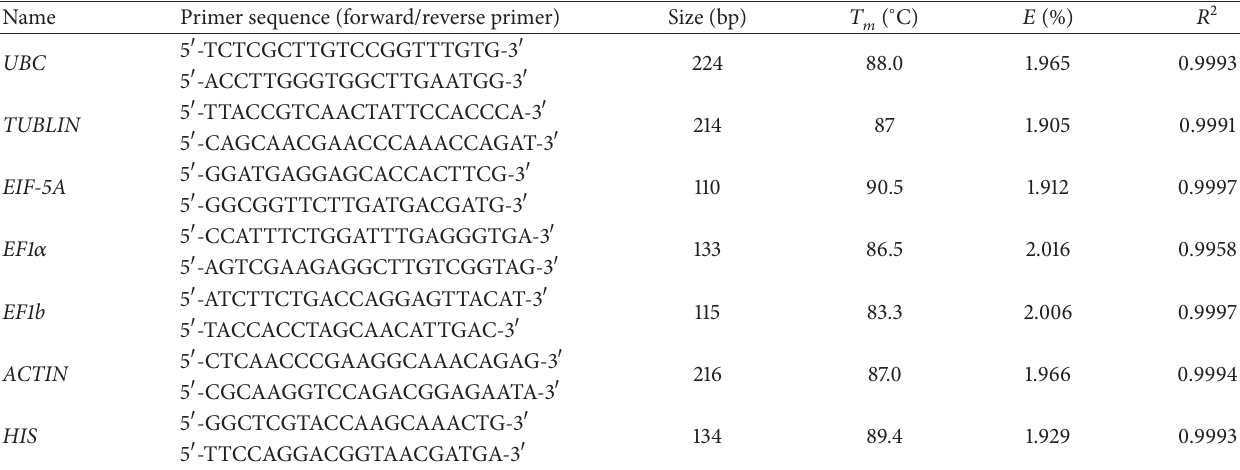
Table 2: Primer sequences and amplicon characteristics for each of the seven reference